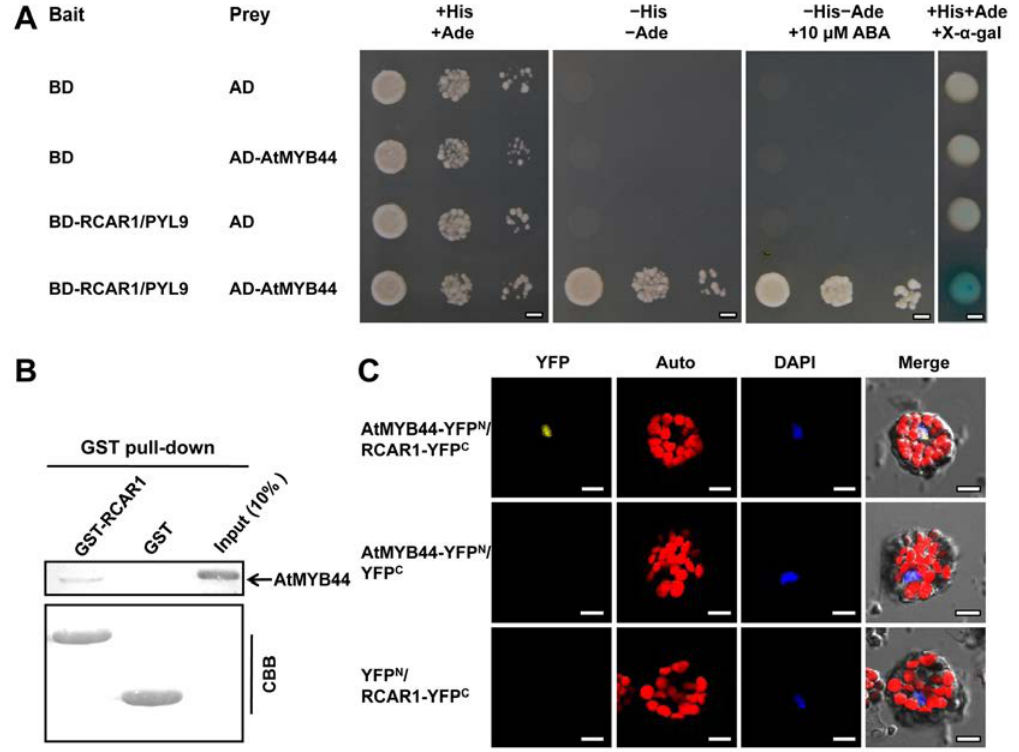
Figure 1. Physical interaction between AtMYB44 and RCAR1/PYL9 in vitro and in vivo . ( A ) Yeast two-hybrid assay. The interaction between AtMYB44 and RCAR1/PYL9 was determined by growth assay and X-α-gal staining on the indicated medium. When indicated, the medium was supplemented with 10 μM ABA. Dilutions (0.1, 0.01, and 0.001) ( left three panels ) or dilution (0.1) ( right panel ) of saturated yeast cultures containing the indicated plasmids were spotted on the indicated plates, and photographs were taken after 3 days at 30 °C. BD (for DNA binding domain) indicates pGBKT7 vector; AD (for transcription activation domain) indicates pGADT7 vector. Scale bars = 2.5 mm; ( B ) GST pull-down assay. 5 μg of recombinant His-AtMYB44 protein was incubated with GST or GST-RCAR1/PYL9 in GST affinity resin. The eluates were resolved by SDS-PAGE and blotted using anti-His antibody. The position of His-AtMYB44 is indicated by an arrow. CBB (Coomassie Brilliant Blue) staining indicates amounts of GST-tagged proteins. Three independent experiments were performed and similar results were obtained; and ( C ) BiFC assay in Arabidopsis protoplasts. The N -terminal half of YFP was fused to AtMYB44 (AtMYB44-YFP N ), and the C -terminal half of YFP was fused to RCAR1/PYL9 (RCAR1-YFP C ). The combinations of plasmids are shown on the left. Co-expression of AtMYB44-YFP N and YFP C or YFP N and RCAR1-YFP C was used as a negative control, respectively. The nuclei were stained by DAPI. Scale bars = 10